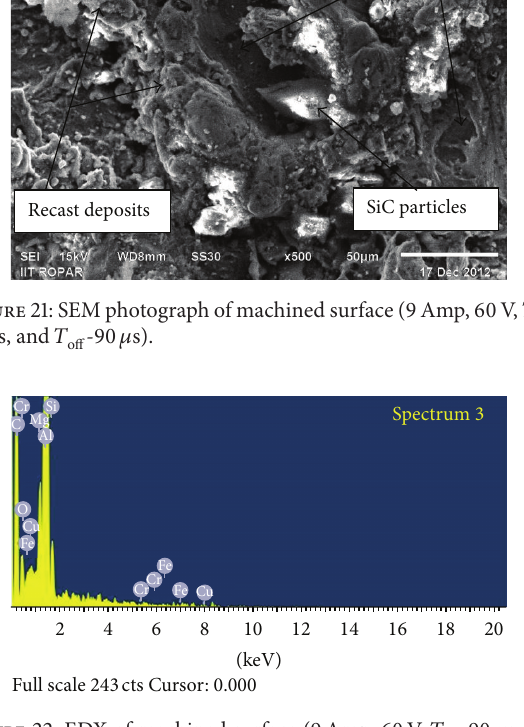
Figure 22: EDX of machined surface (9Amp, 60V, 𝑇 on -90 𝜇 s, and 𝜇 𝑇 off -90